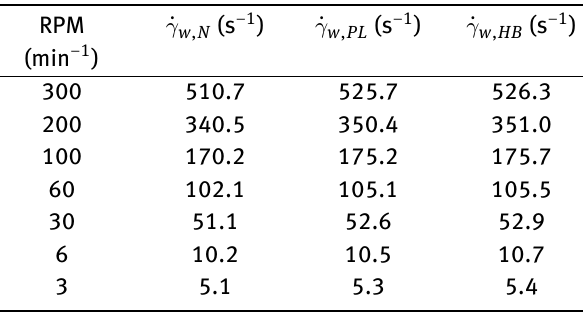
Figure 9: Herschel-Bulkley model fitting of the cement slurry mea- surements listed in Table 1. We plot fits assuming both standard Newtonian shear rates, power law shear rates and Herschel-Bulkley shear rates. Table 4: Newtonian, power law and Herschel-Bulkley wall shear rates for the cement slurry measurements in Table 1.